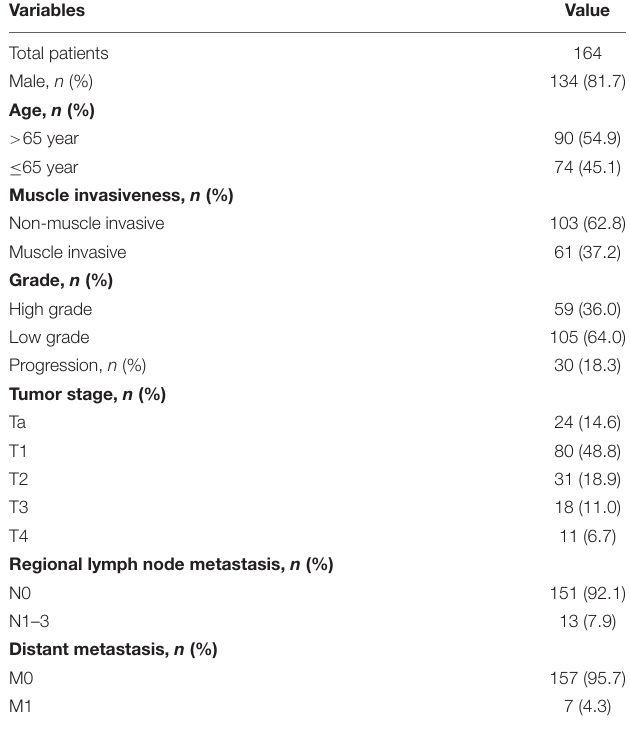
TABLE 1 | Clinicopathological characteristics of patients included in this study